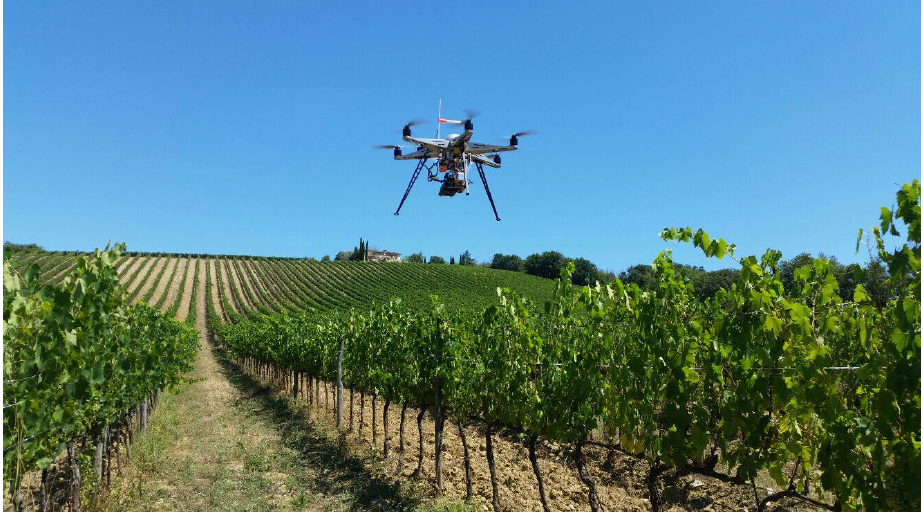
Figure 2. UAV ( unmanned aerial vehicle) platform used in all experimental sites. Figure 2. UAV (unmanned aerial vehicle) platform used in all experimental sites.